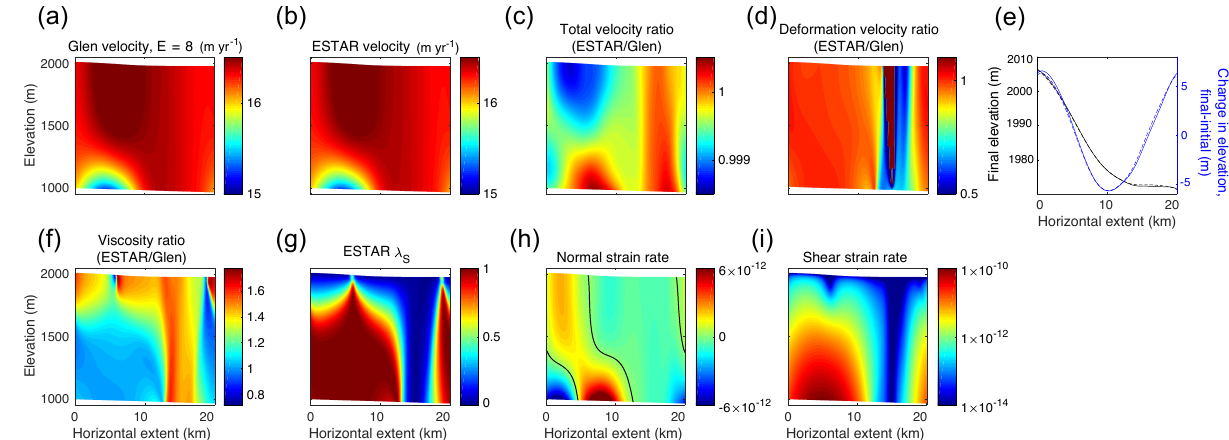
Figure 8. ISMIPDp full-Stokes steady-state results with horizontal extent L = 20km. (a) Glen horizontal velocity v x (myr − 1 , with E G = 8); (b) ESTAR v x (myr − 1 ); (c) ratio of ESTAR / Glen v x ; (d) ratio of ESTAR / Glen deformation v x ; (e) steady-state surface elevation (black) and difference between steady state and initial surface elevation (blue) for ESTAR (solid) and Glen (dashed); (f) ratio of ESTAR / Glen viscosity; (g) ESTAR λ S ; (h) ESTAR normal strain rate (s − 1 ); and (i) ESTAR shear strain rate (s − 1 ). The black contours in (h) correspond to the curves where ˙ ε xx = 0. Note the log scale in (i)